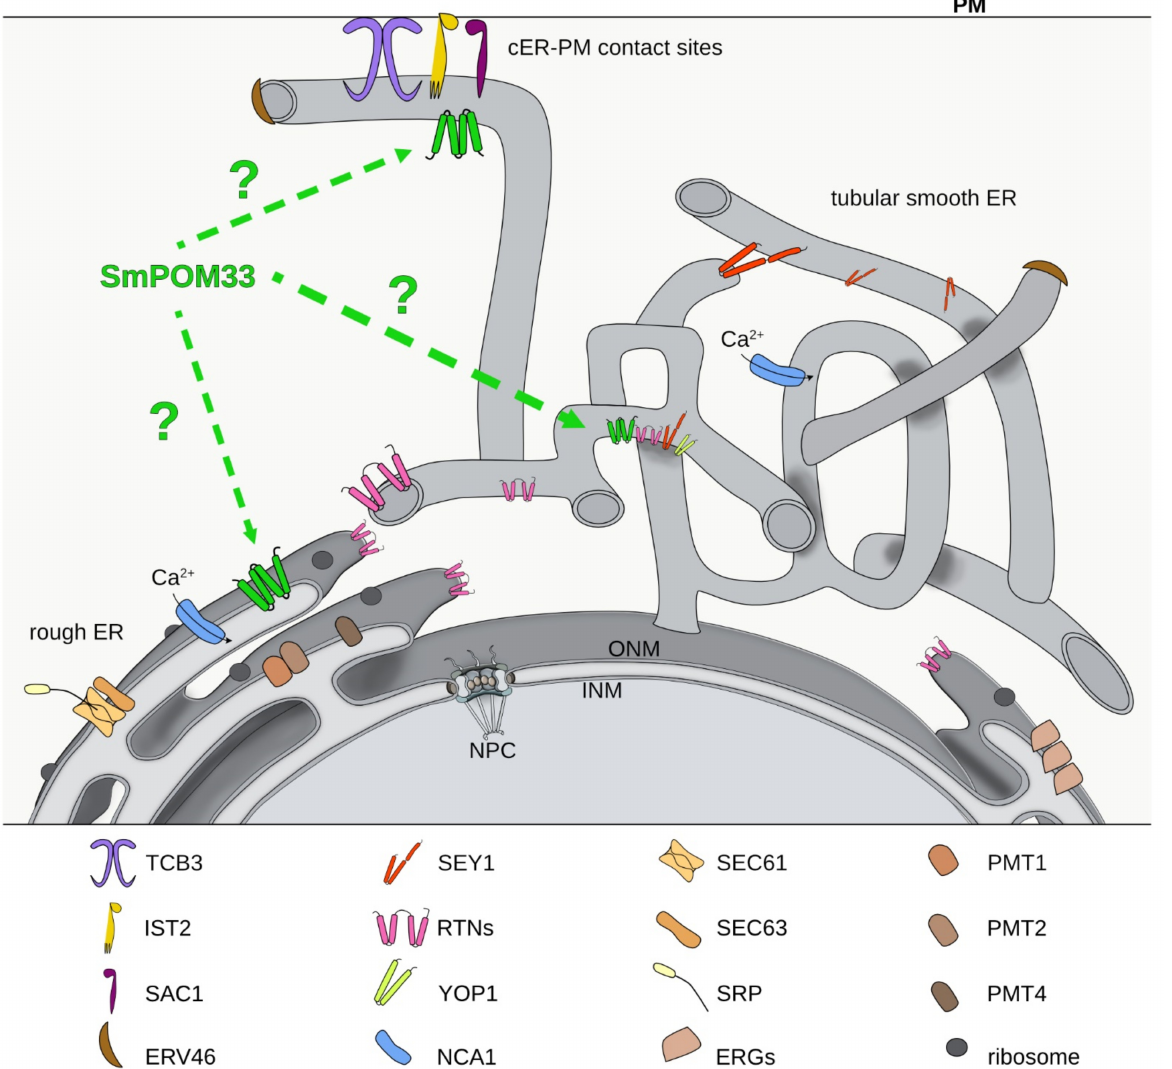
Figure 6. Schematic illustration of putative SmPOM33 localization and its potential interaction partners. Shown are the putative localization of SmPOM33 and the discussed proteins identified via pulldown experiments coupled to LC/MS analysis (Table S4 in Supplementary Materials). Putative interactions partners of SmPOM33 are located at the ER-membrane of the rough or tubular smooth ER. NPC: nuclear pore complex, INM: inner nuclear membrane, ONM: outer nuclear membrane, PM: plasma membrane, cER: cortical